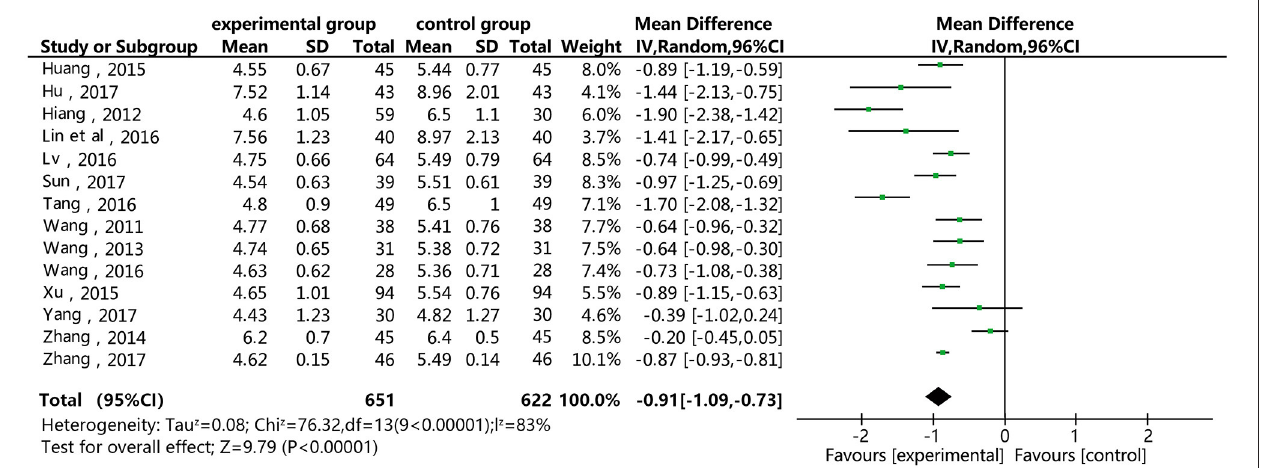
FIGURE 4 | Meta-analysis forest map for the of the effect of DSP combined with aspirin on TC in patients with